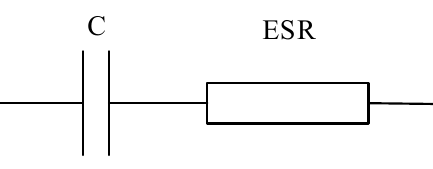
Figure 7. Simplified circuit of a capacitor.